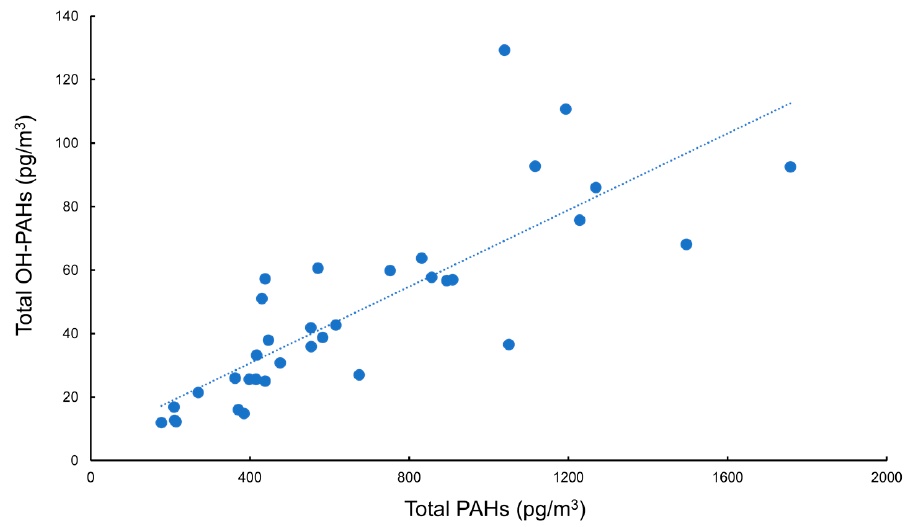
Figure 3. Correlations between the atmospheric concentrations of total PAHs and OH-PAHs. particles, such as PM 2.5 . Atmospheric concentrations of PM 2.5 were highest in spring 2017 (21.7 ± 12.1 µ g/m 3 ), spring 2018 (17.5 ± 9.6 µ g/m 3 ), winter 2018 (14.2 ± 2.6 µ g/m 3 ), autumn 2017 (12.3 ± 5.1 µ g/m 3 ), and summer 2017 (10.6 ± 4.3 µ g/m 3 ) [2]. There were